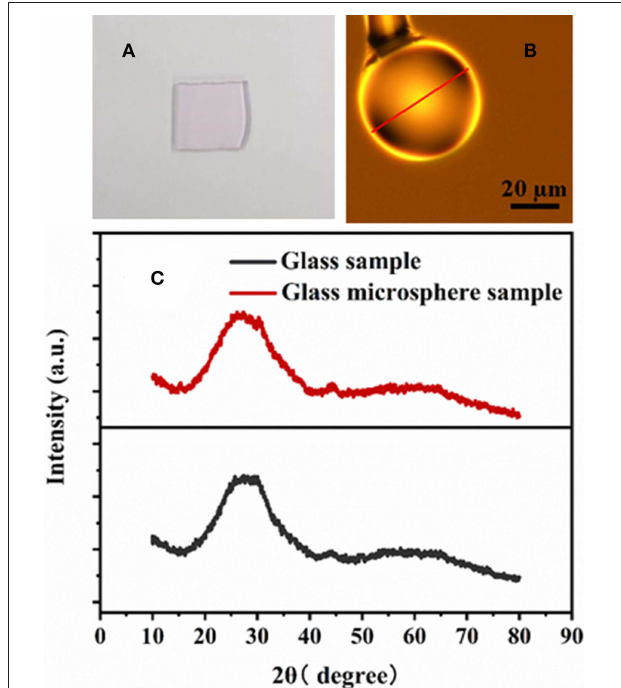
FIGURE 3 | (A) Photograph of the bulk glass samples with composition 16ZnF 2 -68SiO 2 -16KF-0.4Nd 2 O 3 (in mol%). (B) Microscope image of the glass microsphere. (C) XRD of the bulk glass and glass microsphere samples.